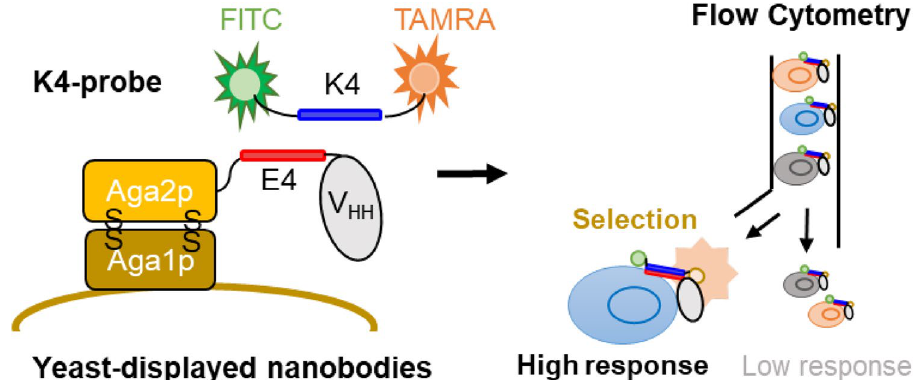
Figure 1. Schematic image of yeast-displayed mini Q-body and its selection steps. Nanobody-based Q-body (mini Q-body) was assembled on the yeast cell surface via E4/K4 interaction. To select potent mini Q-bodies, K4 peptide labeled with FITC and TAMRA was used to evaluate the quenching and de-quenching of TAMRA by flow